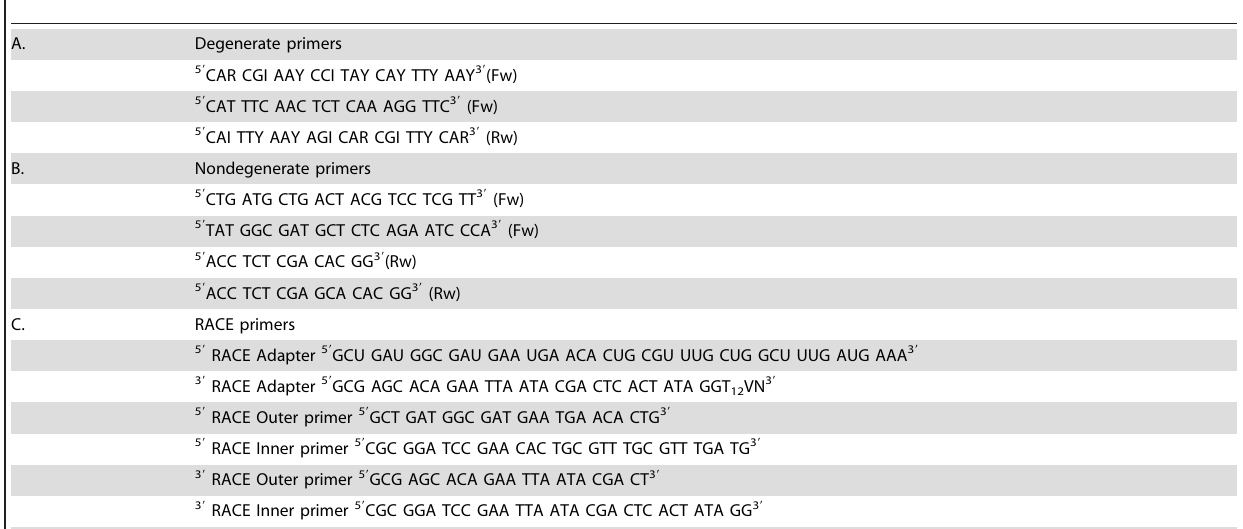
Table 2. Sequence of the primers used to sequence the cDNA encoding blad and the b -conglutin precursor.